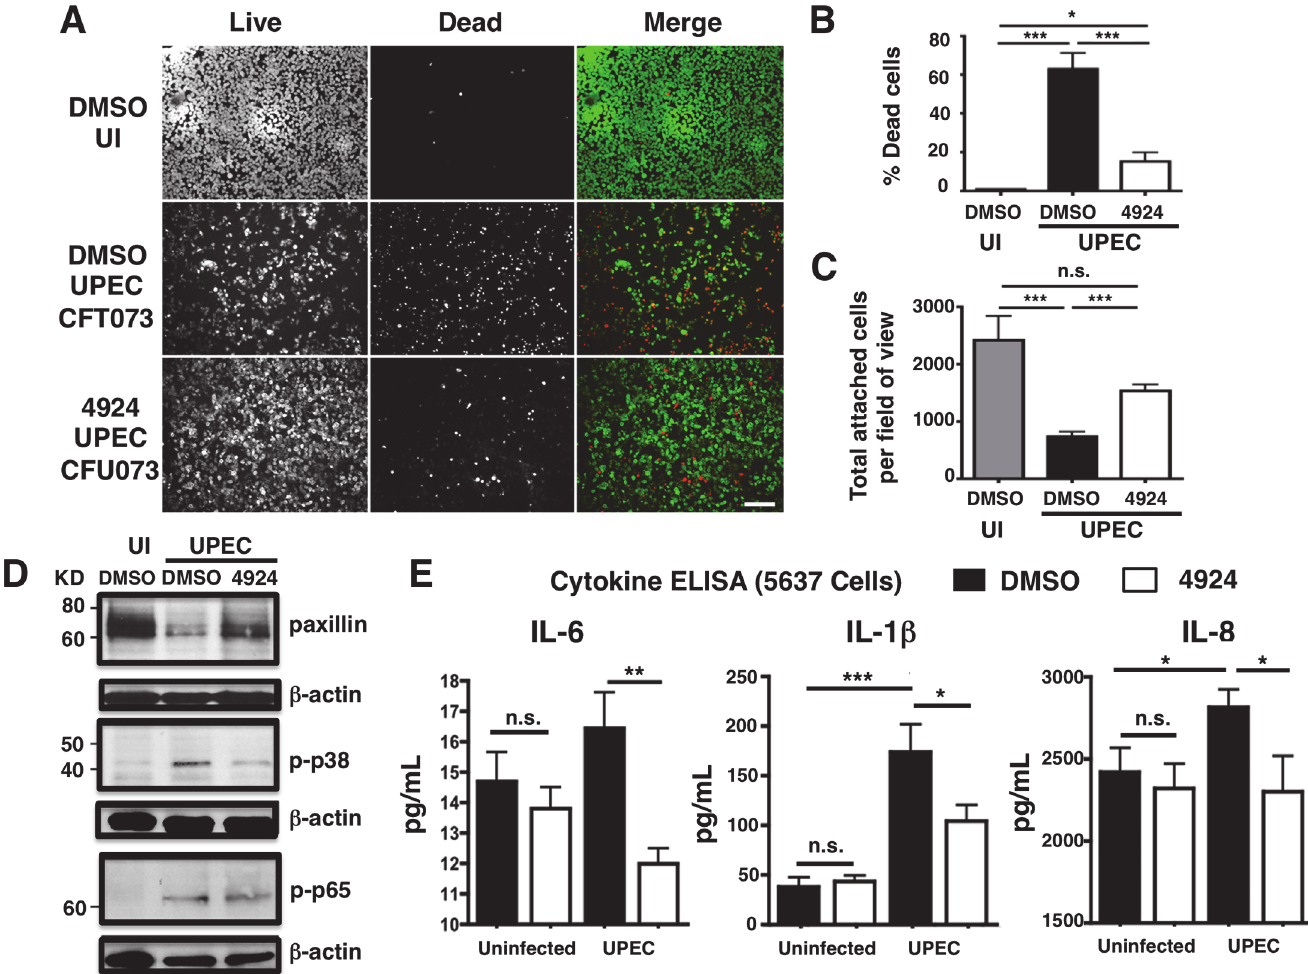
Fig 2. AKB-4924 reduces UPEC-mediated cytotoxicity and inflammation in human uroepithelial cells. 5637 Cells were infected with UPEC CFT073 for 2h at MOI ~20. ( A ) Live/dead cell staining illustrates viable (green) or dead (red) cells. Scale bar = 100 μ m. ( B ) Percentage death in uninfected (UI), DMSO and AKB-4924 pre-treated 5637 cells (n > 7). ( C ) Total attached cells per field of view. Counts were made from multiple random fields of view (10x objective, n > 7) from independent samples (n = 3). Error bar = S.E.M, *** P < 0.001, ** P < 0.01, * P < 0.05 by student ’ s two-tailed unpaired t-test. ( D ) Western blots of paxillin, phospho-p38 and phospho-p65 expression of uninfected (UI), UPEC-infected 5637 cells with prior exposure of DMSO or AKB-4924 (n = 3 per group). Data represent one of two independent experiments. ( E ) ELISA detection of pro-inflammatory cytokine proteins IL-6, IL-1 β and IL-8 released by DMSO or AKB-4924 pre-treated 5637 cells 2 h post- infection (n = 4 per group). Results are pooled from 3 independent experiments.